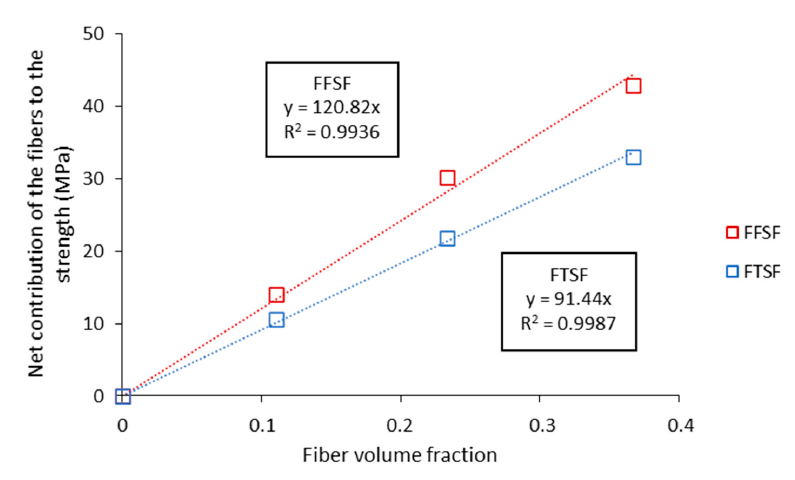
Figure 7. Fiber tensile strength factor (FTSF) and fiber flexural strength factor (FFSF).